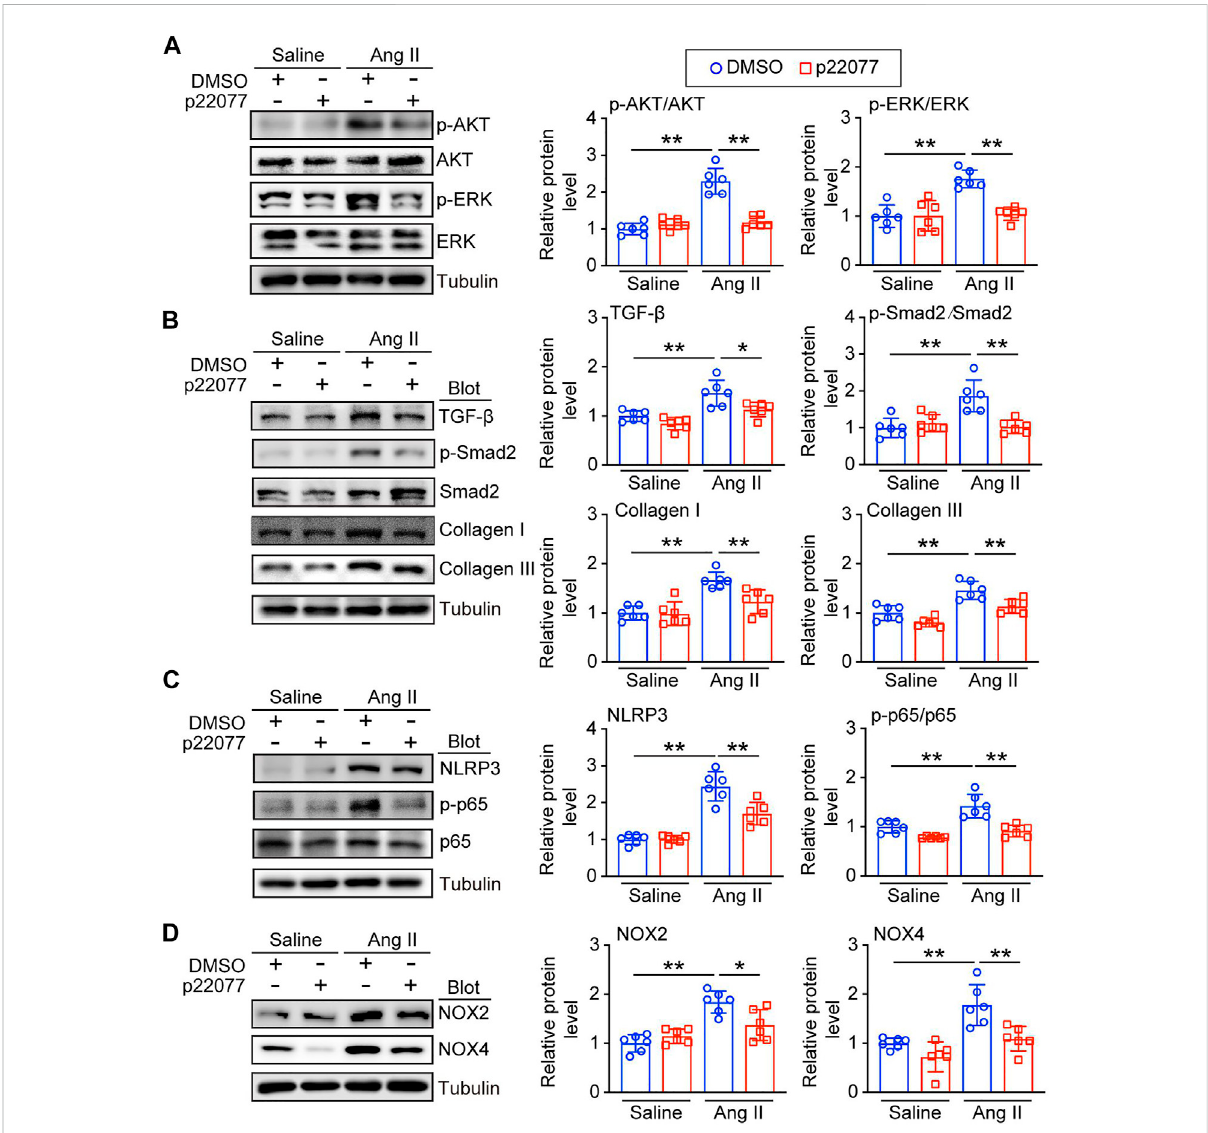
FIGURE 6 Administration of p22077 regulates multiple signaling pathways in Ang II-induced cardiac remodeling. (A) Representative immunoblotting analysis of p-AKT, AKT, p-ERK, ERK, and Tubulin in heart tissues from each group (left). Quanti fi cation of the relative protein levels (right, n = 6). (B) Representative immunoblotting analysis ofTGF- β 1,p-Smad2,Smad2,Collagen I,Collagen III,andTubulin(left).Quanti fi cationoftherelativeprotein levels by densitometry (right, n = 6). (C) Representative immunoblotting analysis of NLRP3, p65, p-p65, and Tubulin (left). Quanti fi cation of the relative protein levels (right, n = 6). (D) Representative immunoblotting analysis of NOX2, NOX4, and Tubulin (left). Quanti fi cation of the relative protein levels (right, n = 6). The data are presented as the mean ± SD, and n represents the number of animals per group. * p < 0.05, and ** p <